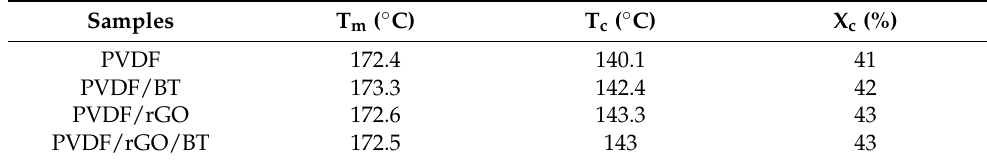
Table 1. DSC results for PVDF and its nanocomposite fibers.